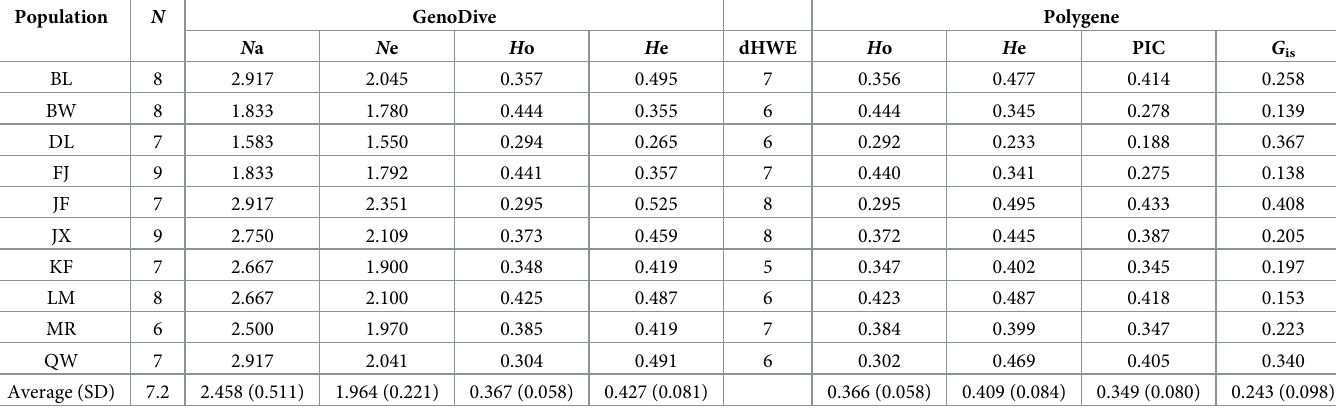
Table 3. Genetic diversity of Hopea hainanensis populations based on 12 SSR markers. Population N GenoDive